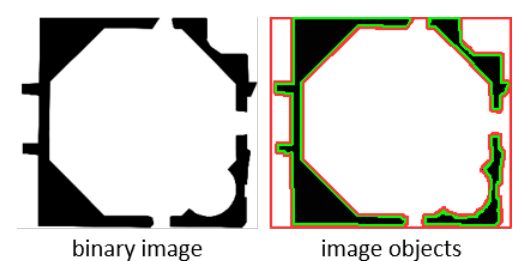
Figure 10. From the binary image (left) to the image objects (right) by means of the segmentation; the red line represents the background, the green line coincides with the image object representing the masonry